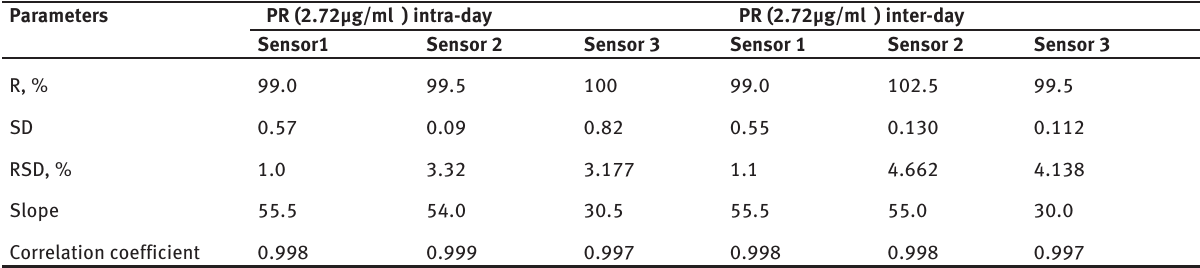
Table 3: Accuracy and precision of the PR-PVC sensors.